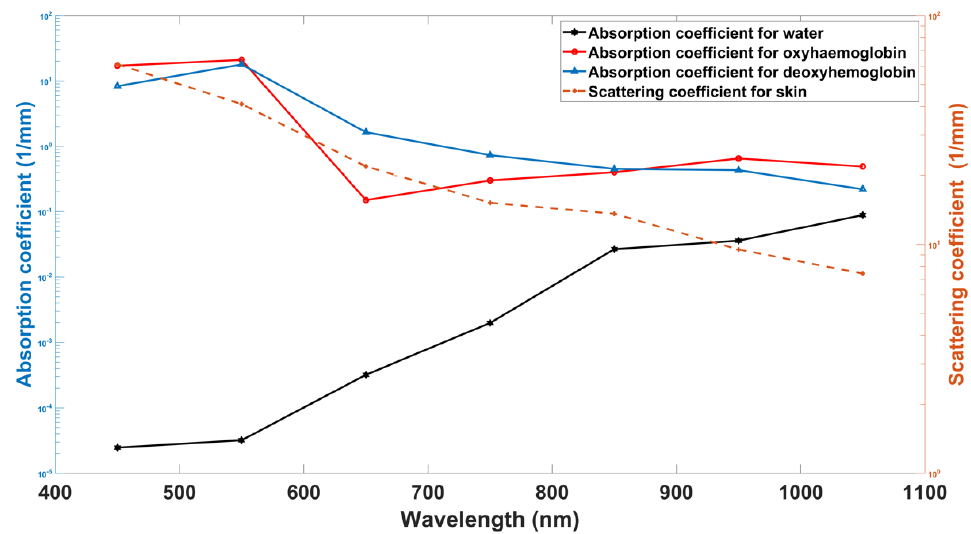
Figure 2. Other optical properties values in the utilized in MCS model: scattering coefficients μ s and absorption coefficients for water ( µ H 2 O a ), deoxyhemoglobin ( µ Hb a ), and oxyhemoglobin ( µ HbO 2 a ) [27,31,38].